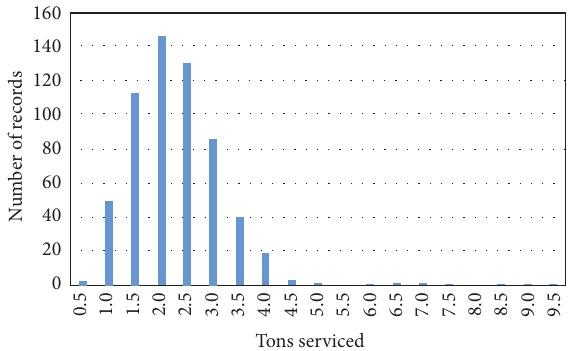
Figure 3: Variability in weight per service for 30-yard